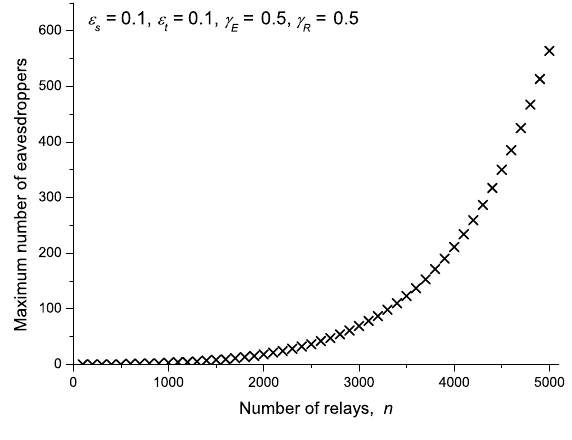
Figure 4. Maximum number of eavesdroppers for Protocol 2 vs.